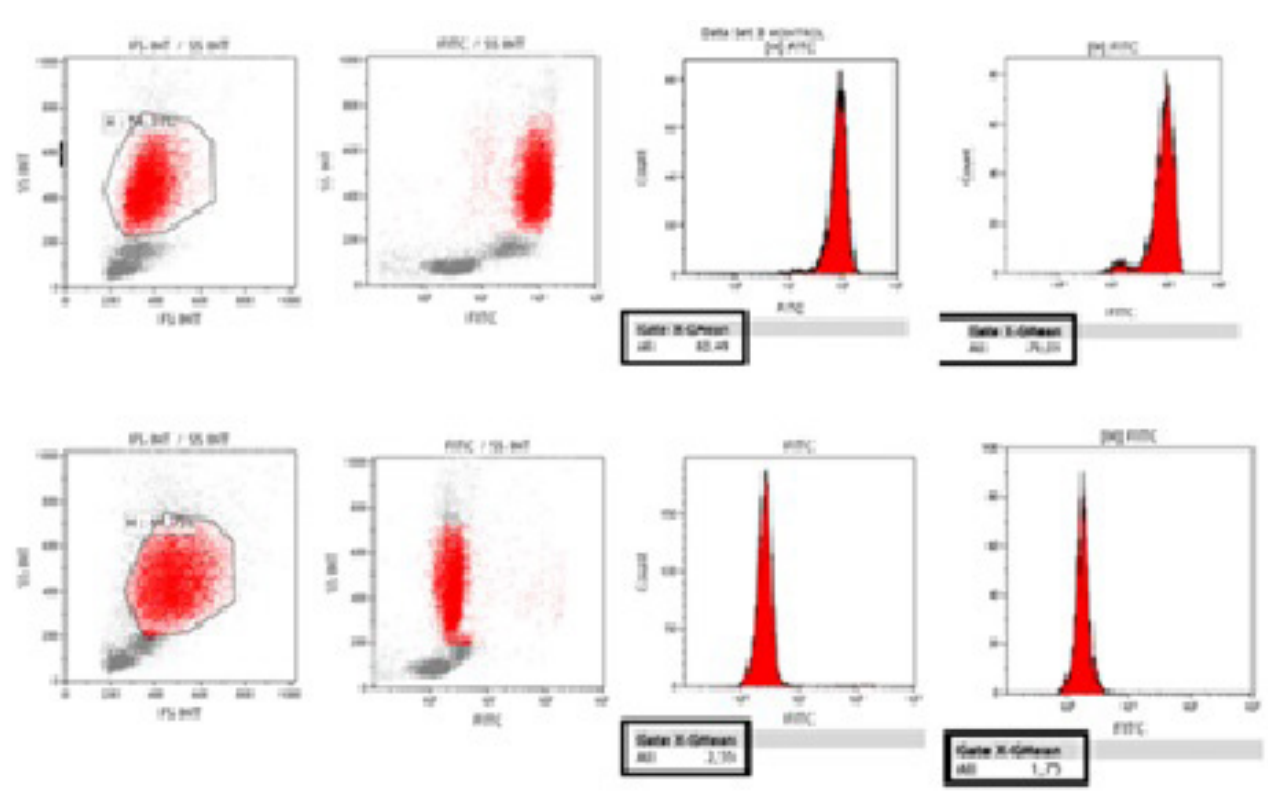
Fig. 4 - Dihydrorhodamine (DHR) histogram pattern showing patient (P1) and control (C1) results with mean stimulation index (SI) values. Phorbol 12-myristate 13-acetate (PMA) is a suitable stimulating agent for determining the function of neutrophils, nicotinamide adenine dinucleotide phosphate oxidase enzyme, and helps to determine the activation of neutrophils. DHR, on the other hand, is a fluorescent-acting antibody that indicates whether PMA activates neutrophils in the fluorescein isothiocyanate channel. Expression levels of neutrophils before stimulation with the upper panel were determined according to the increasing fluorescence intensity in the neutrophils after PMA stimulation with the lower panel. Histogram and point plots of the control sample were created by calculating the SI values of the patient and control samples exposed to the DHR 123 test PMA. By comparing both patient and control samples, P-value (patient [n=30], control [n=10]; P=0.154) was obtained. The mean SI value was found to be 60.40±7.86 in the patient group and 75.10±5.21 in the control group